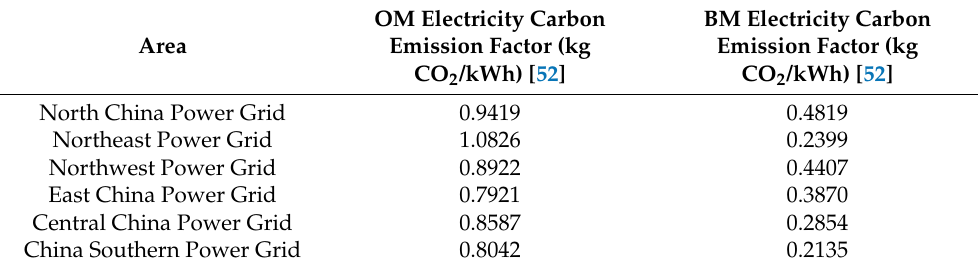
Table 5. Critical electricity CEFs in six major regions in China in